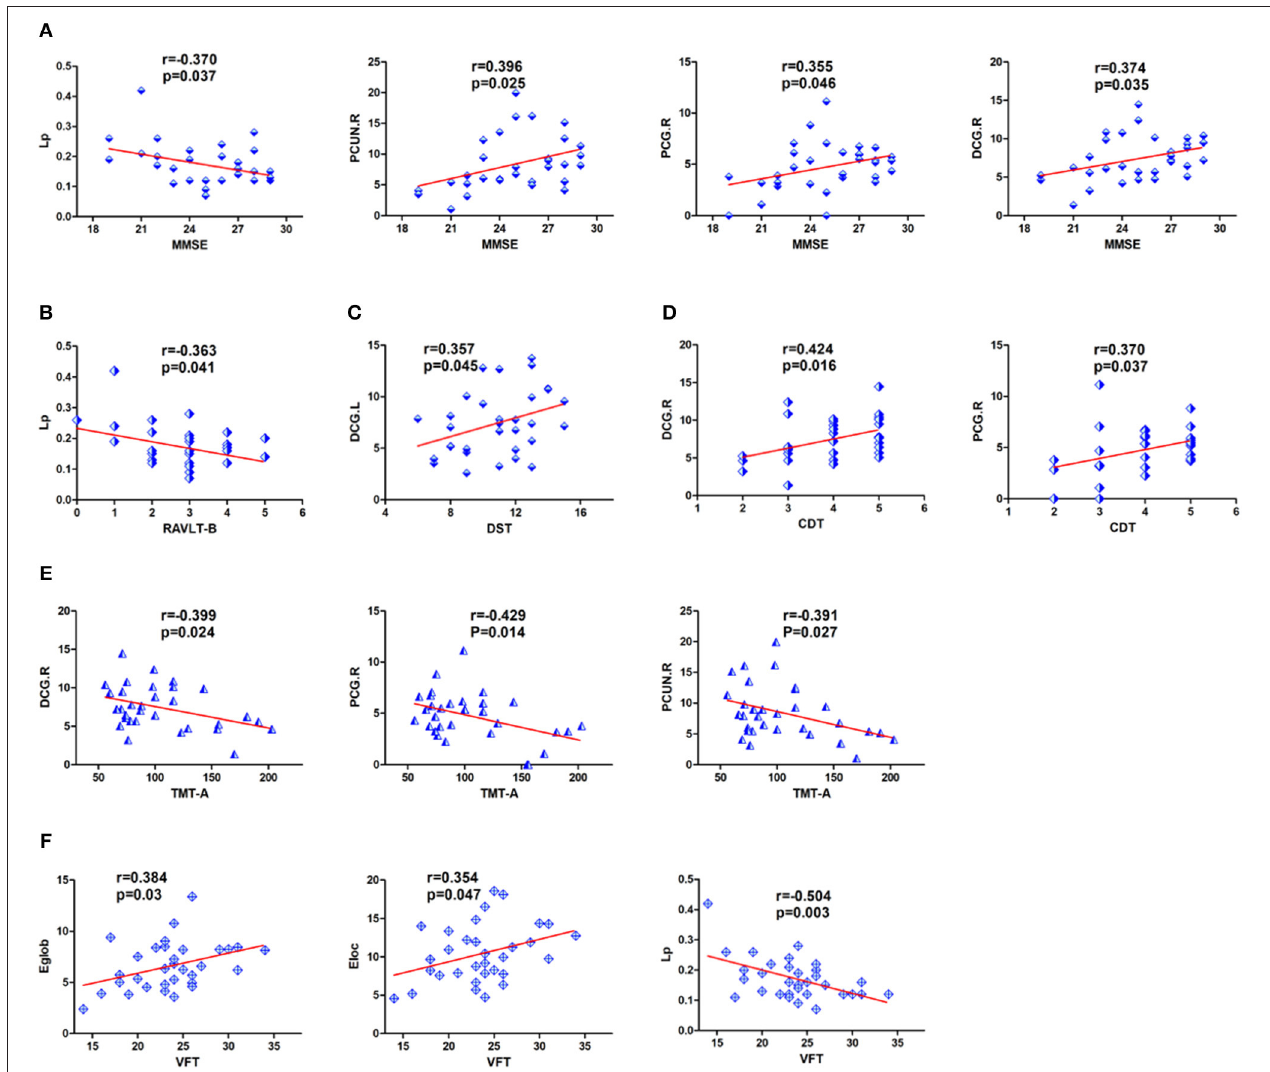
FIGURE 5 | Detailed display of the correlations between neuropsychological scores and regional nodal efficiency and network parameters in patients with cerebral infarction. (A) MMSE was significantly correlated with nodal efficiency in DCG.R, PCUN.R, PCG.R and Lp . (B) RAVLT-B showed a significant negative correlation with Lp . (C) DST showed a significant positive correlation with nodal efficiency in DCG.L. (D) CDT scores were positively correlated with the nodal efficiency of DCG.R and PCG.R. (E) TMT-A showed a significant negative correlation with nodal efficiency in DCG.R, PCG.R, and PCUN.R. (F) VFT showed a significant correlation with Eloc, Lp and Eglob. For the abbreviations of nodes and neuropsychological scores, see Tables 1 , 3